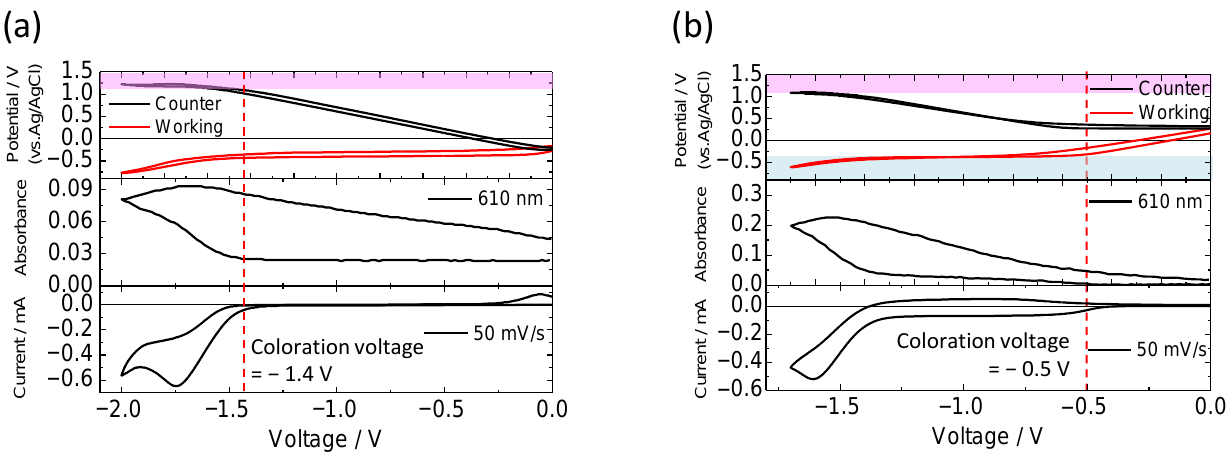
Figure 5. CVs of two-electrode electrochemical device (bottom), in situ absorption change at 610 nm (middle), and in situ electrode potentials (vs. Ag/AgCl) of working and counter electrodes. ( a ) Flat ITO/flat ITO device and ( b ) flat ITO/ITO particle-modified electrode device.